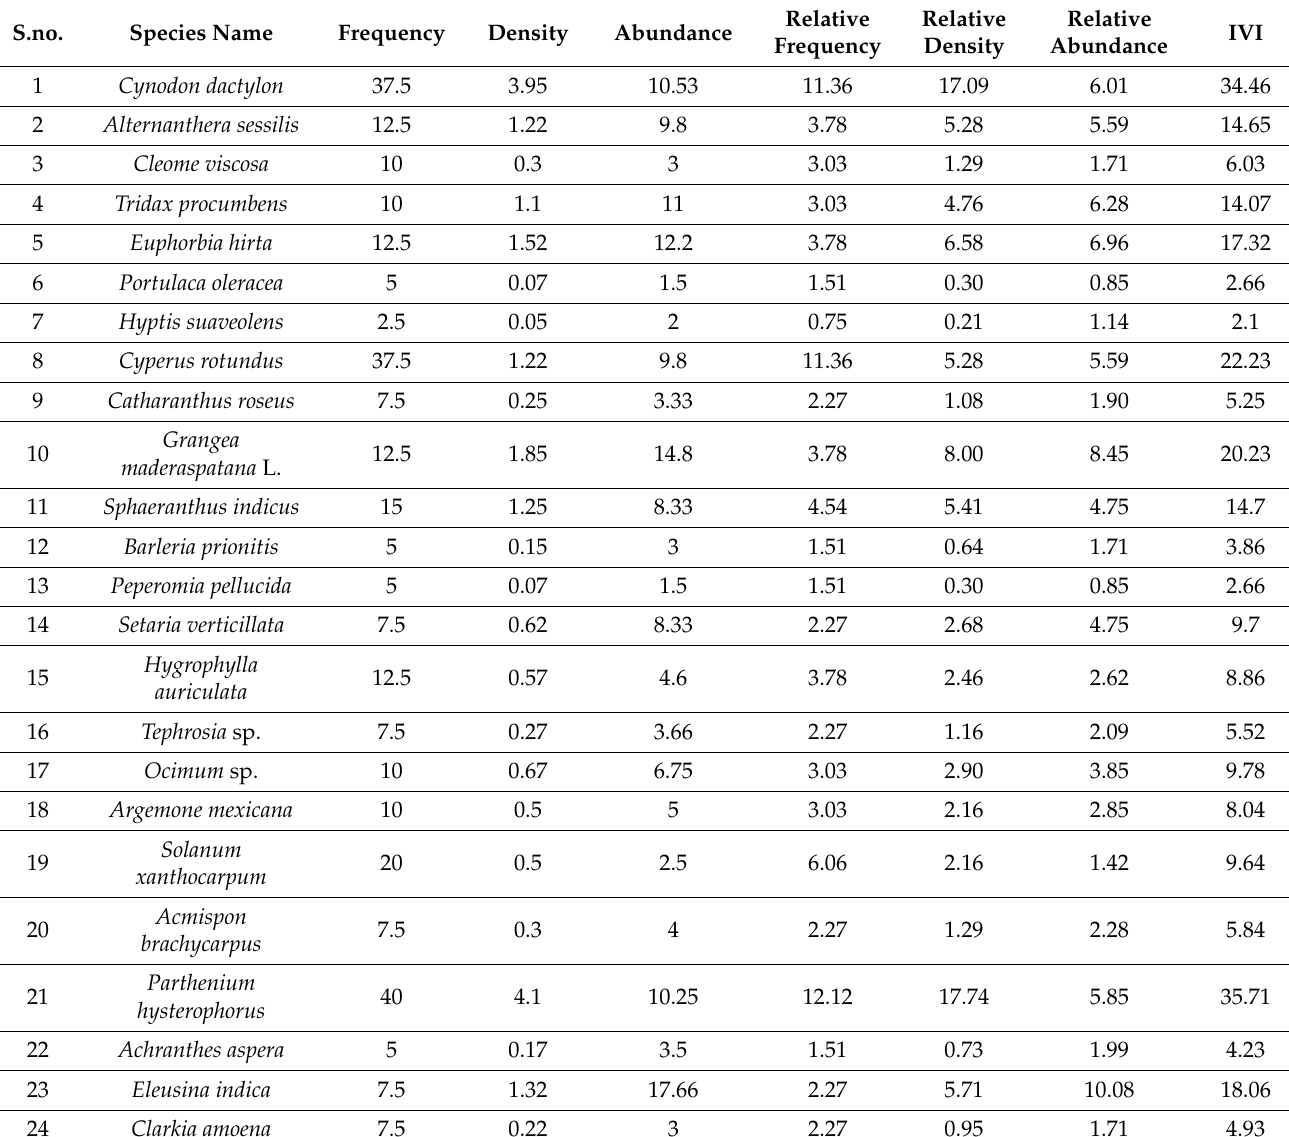
Table 2. Calculation for herbaceous species from NTPC, Sipat (Site